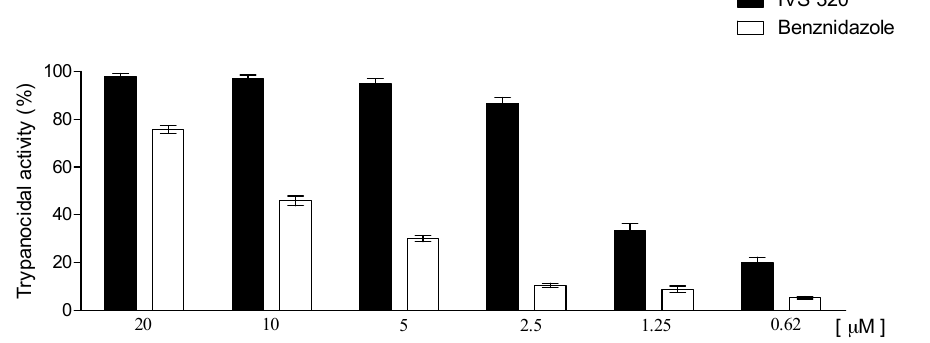
Figure 5. Effect of IVS320 upon the viability of trypomastigotes.